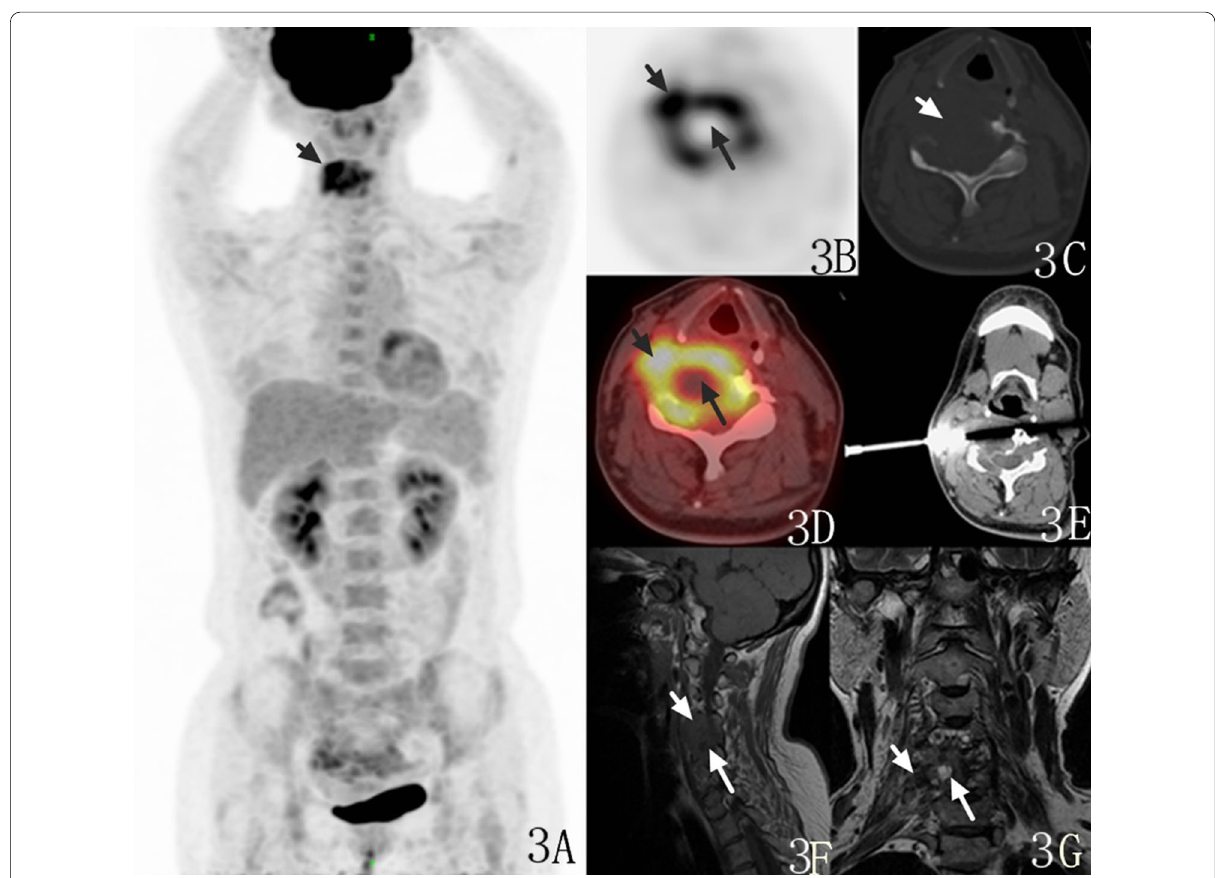
Fig. 3 A 47-year-old female with malignant GCTTS. PET/CT maximum intensity projection (MIP) images revealed increased but heterogeneous uptake of FDG in the C4-6 vertebra ( A , arrow), and no other lesions were found in any part of the body. The spinal lesion shows heterogeneous FDG uptake with central deficiency ( B , D , long arrow) but higher uptake in the periphery ( B , D , short arrow), with an SUVmax value of 8.9. CT showed irregular osteolytic bone destruction ( C , arrow). CT-guided biopsy was performed on the hypermetabolic area of the lesion ( E ). The lesion showed signal hypointensity on sagittal T1WI image with unclear margin ( F , short and long arrows) and hyperintensity in the central region but hypointensity in the periphery on coronal T2WI images ( G , short and long arrows)